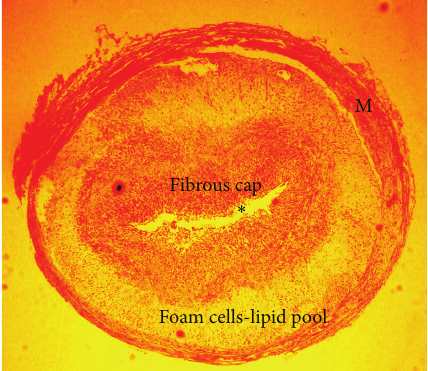
Figure 4: Photomicrograph of a coronary lesion obtained from an Ossabaw pig on a high fat diet. Lumen denoted by ∗ , and M indicates medial layer. Kindly provided by Drs. Michael Sturek and Mouhamad Alloosh, Department of Cellular and Integrative Physiology, Indiana University School of